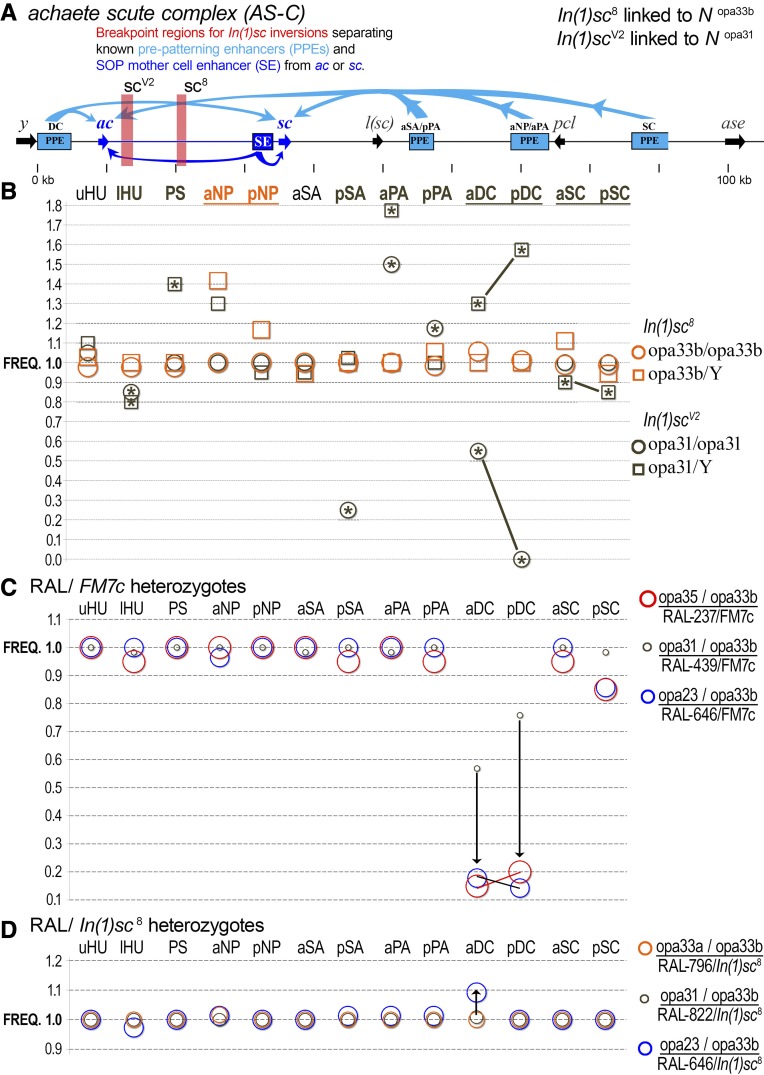
A scute inversion carrying the wild-type opa31 Notch allele manifests a severe bristle patterning defect that is not seen with an equivalent scute inversion carrying the rare expanded opa33b allele. (A) The AS-C locus and positions of the scV2 (linked to opa31) and sc8 (linked to opa33b) inversion breakpoints (light red vertical bars). Also shown are the diverse prepatterning enhancers (blue PPE boxes), which normally drive both ac and sc (blue arrows) in different proneural clusters of developing wing imaginal discs. In addition, the SOP mother cell enhancer (dark blue SE box), which drives both ac and sc, is also shown. Although each inversion is linked to a different Notch opa allele carried within the inversions, both inversions separate the same set of known enhancers. The DC PPE also coincides with the yar noncoding transcript (Soshnev et al. 2011). (B) A comparison of macrochaete patterning defects shows that scV2 has more deleterious effects than sc8, consistent with a suppressor role for opa33b expanded Notch. (C) A comparison of macrochaete defects for RAL F1 heterozygotes over FM7c, which carries the sc8 inversion allele, shows that heterozygotes with the short and long variants are severely deficient in specifying DC and pSC bristles relative to a representative wild type heterozygote. (D) RAL stocks over the sc8 inversion allele by itself (\emph{i.e.}, not in a complex balancer chromosome), shows more modest effects compared to the FM7c heterozygotes and further suggests the presence of N1 modifiers in the latter (see text).